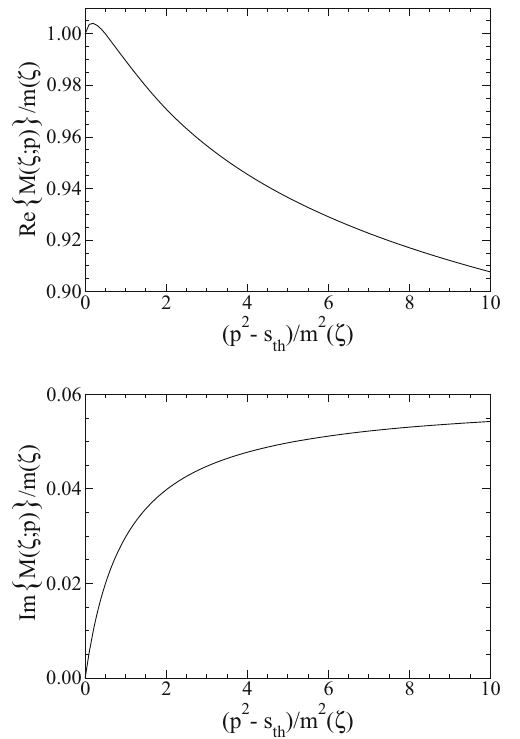
Fig. 7 The same as in Fig. 6, but for the timelike region. Upper panel: the real part. Lower panel: the imaginary